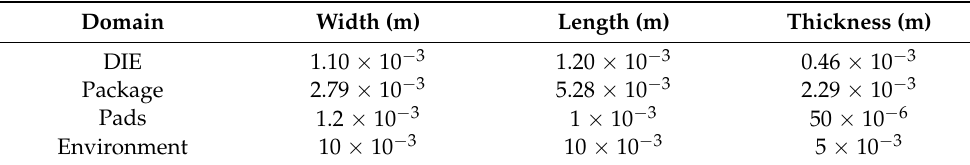
Table 4. Geometrical Parameters of